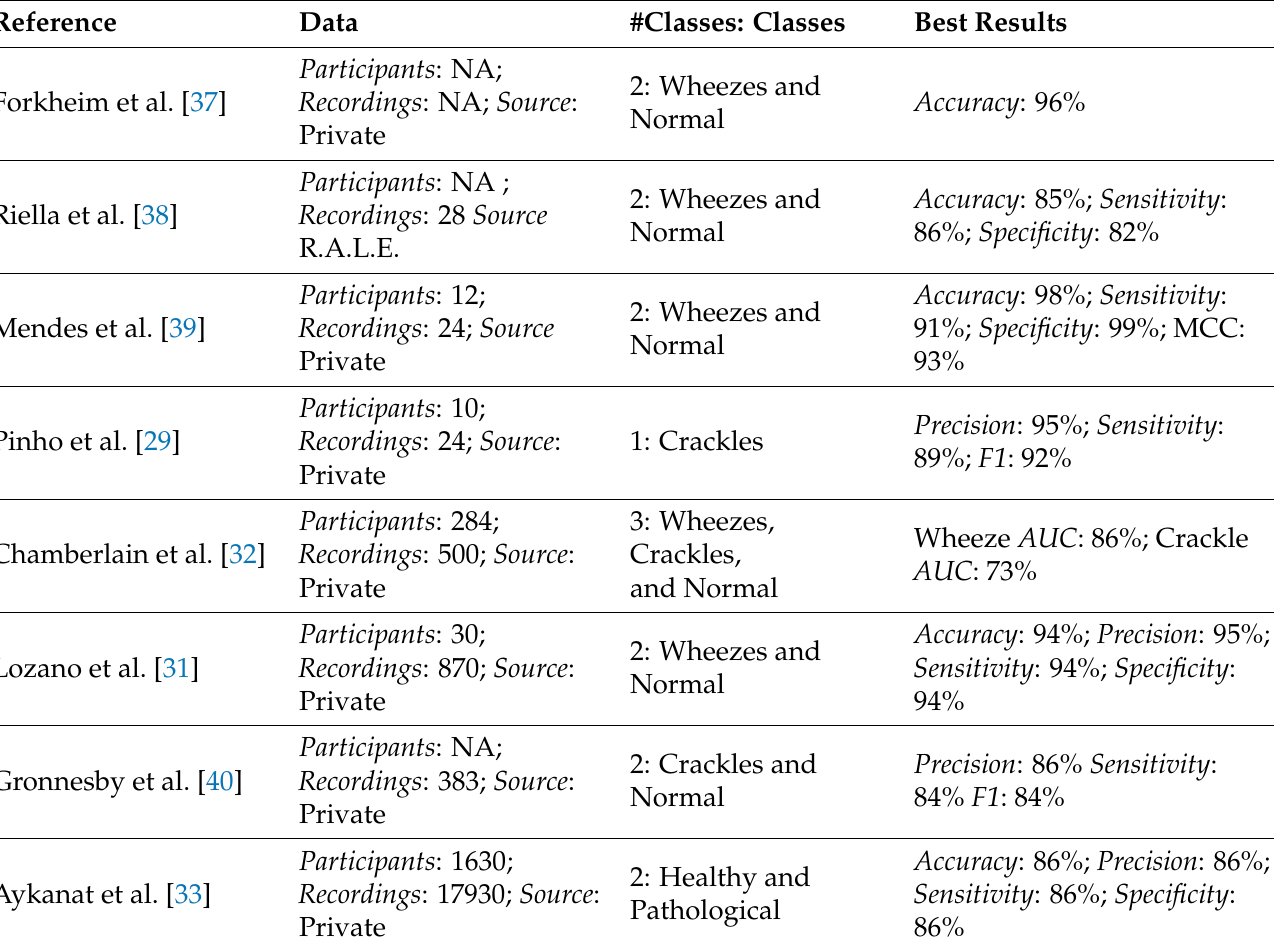
Table 1. Summary of selected